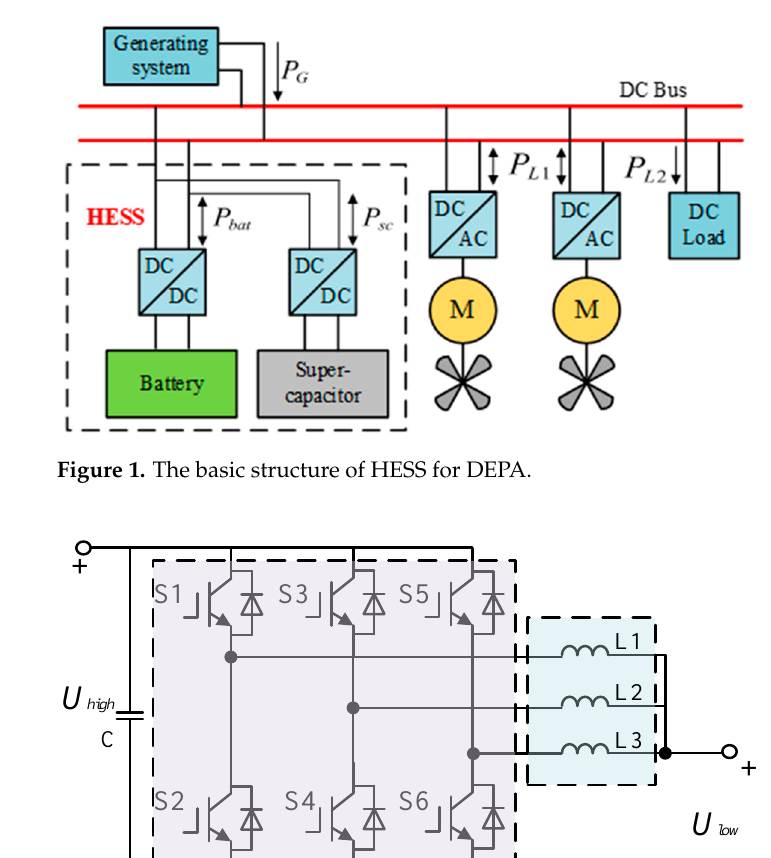
Figure 2. Three-phase interleaved parallel DC-DC converter.